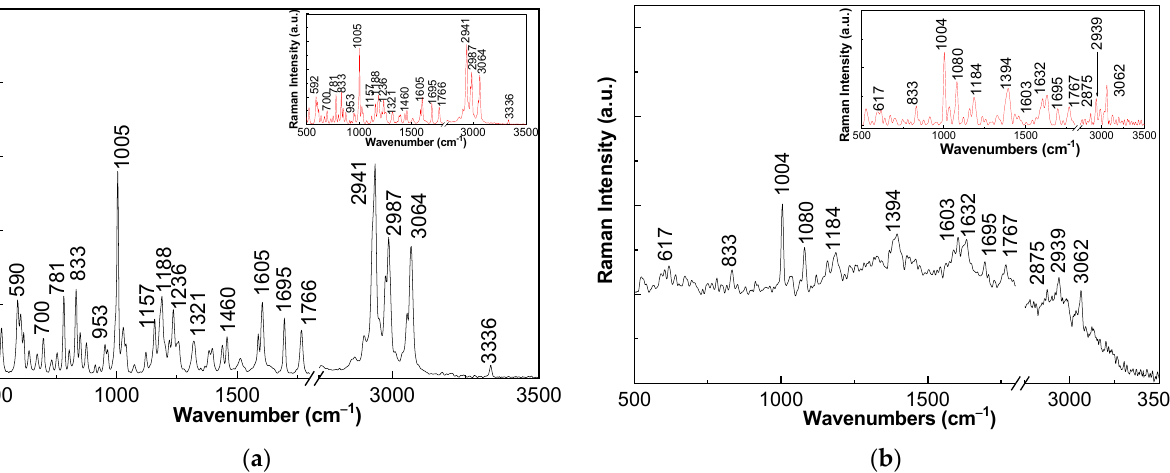
Figure 10. Raman spectra of AM ( a ) and NaOH-reacted AM ( b ). The insert of ( a , b ) shows the Raman spectra after the baseline correction.